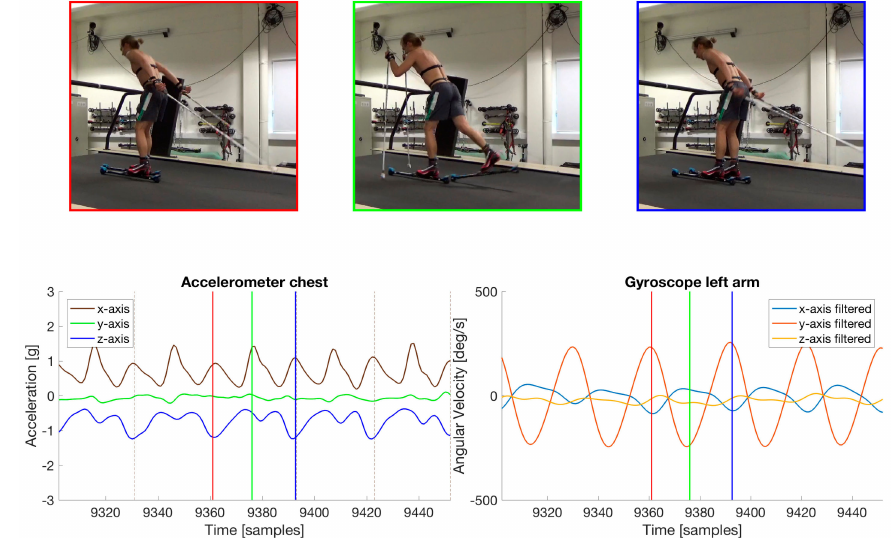
Figure 2. The cycle detection is done by filtering the gyroscope data from one of the arms. The y-axis results in a signal with a clear sinusoidal shape. By synchronizing this signal to a video of the skier we can observe that the peaks in the signal correspond to when the arm is extended all the way behind the athlete. This is indicated with the red and blue vertical lines in the plots. The red and blue vertical lines correspond to the video-frame displayed above with the corresponding color. The minima of the sinusoid on the y-axis corresponds to when the arms plant the poles in front of the skier, as illustrated by the green vertical line and film